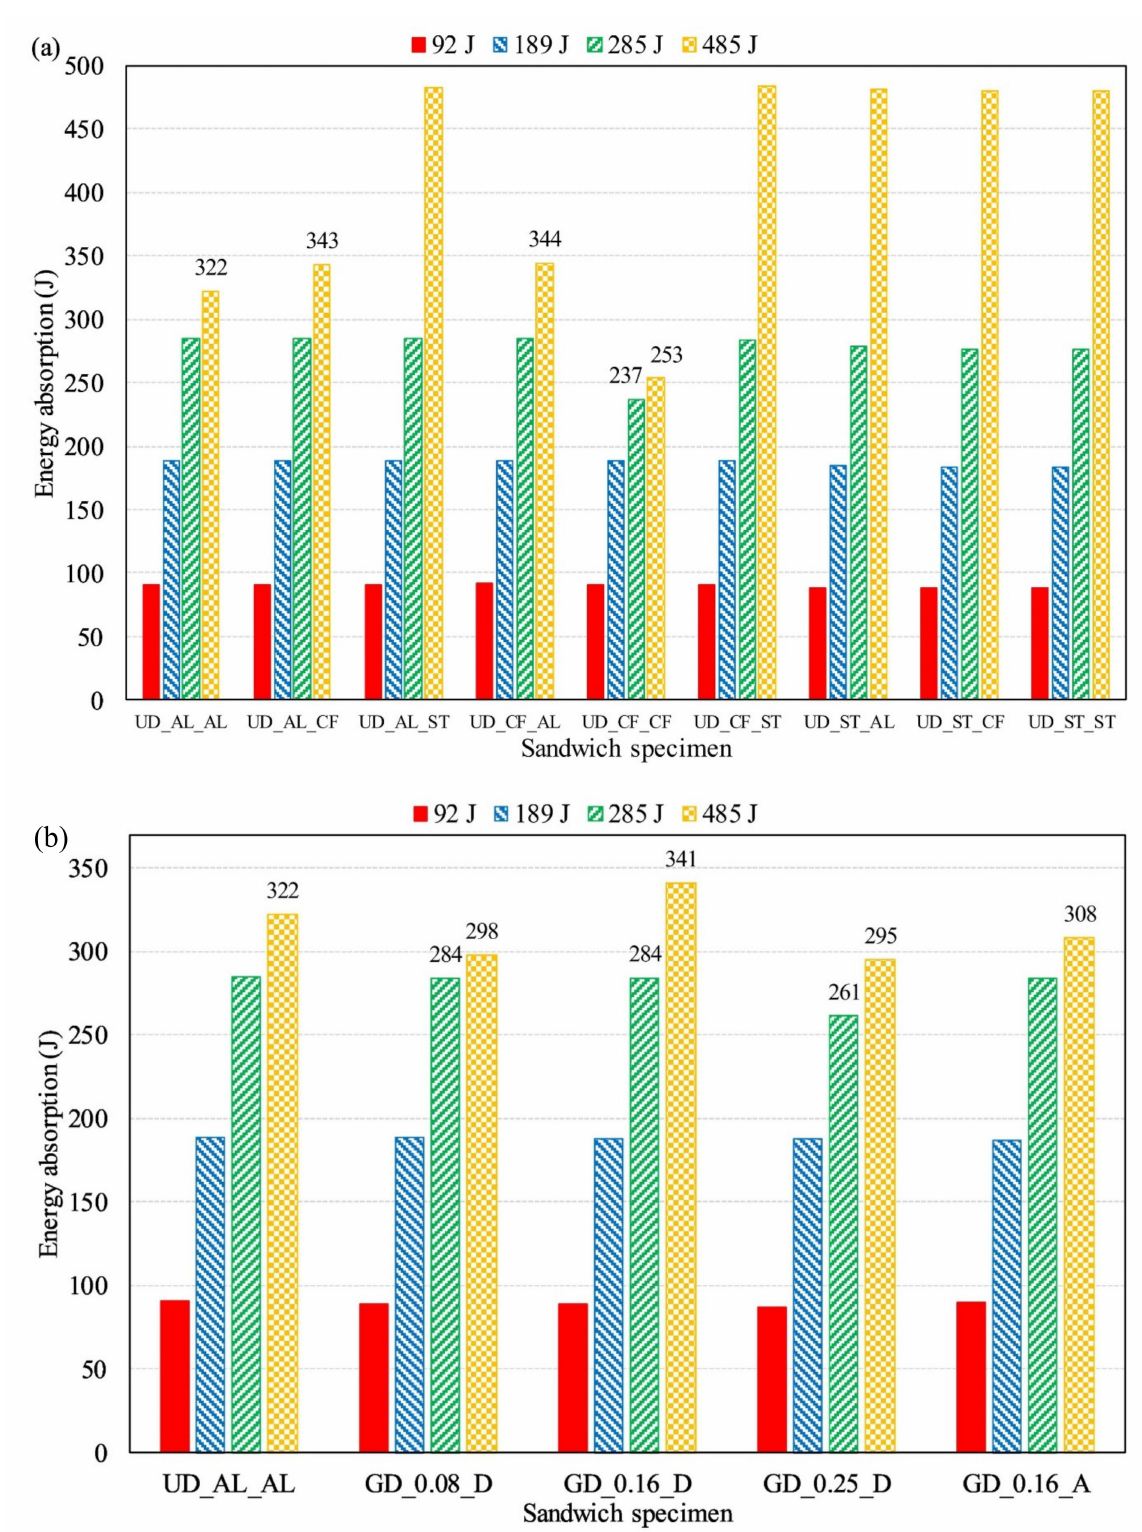
Figure 3. Energy absorption of sandwich panels under different impact energies: ( a ) sandwich panels with different face sheets, ( b ) sandwich panels with homogeneous and various graded foam cores